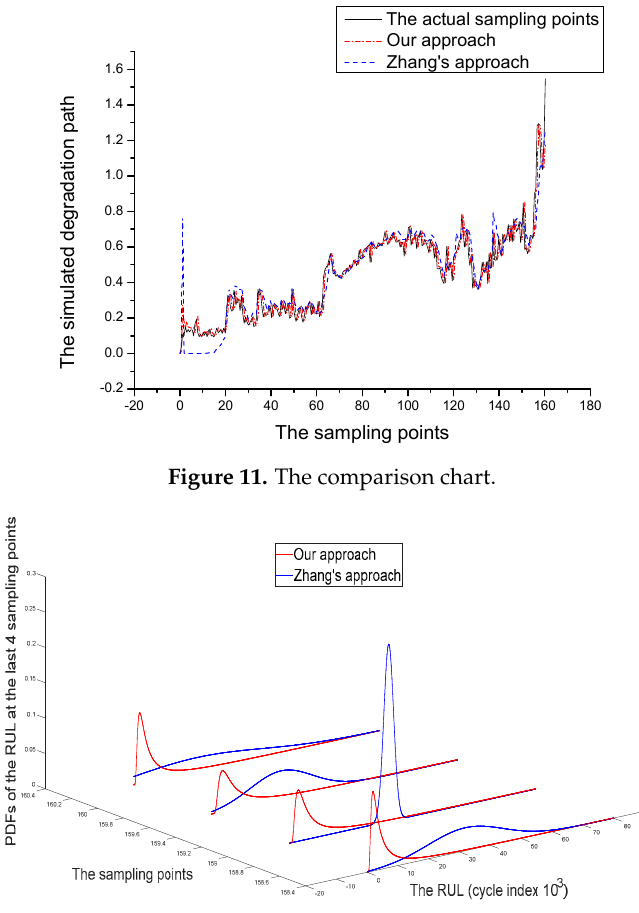
Figure 12. The PDF of RUL at the last four different monitoring points.